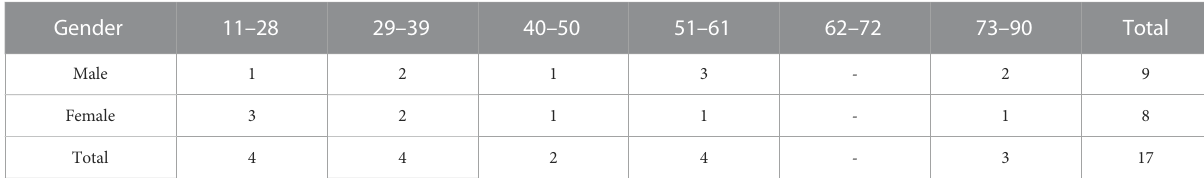
TABLE 2 Patients enrolled in studies 1 and 2, according to age group and